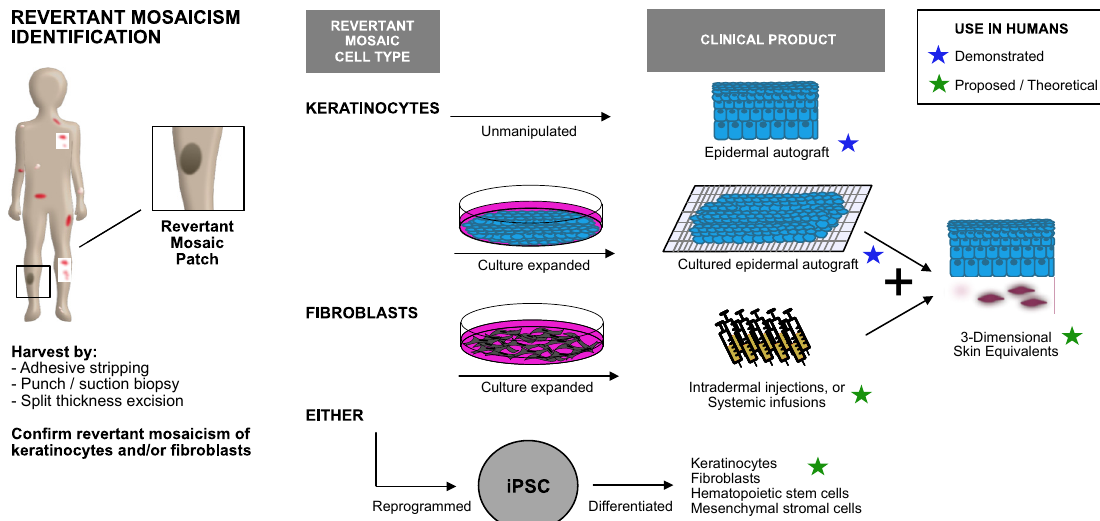
Figure 4. Clinical applications of revertant mosaic skin populations in EB.